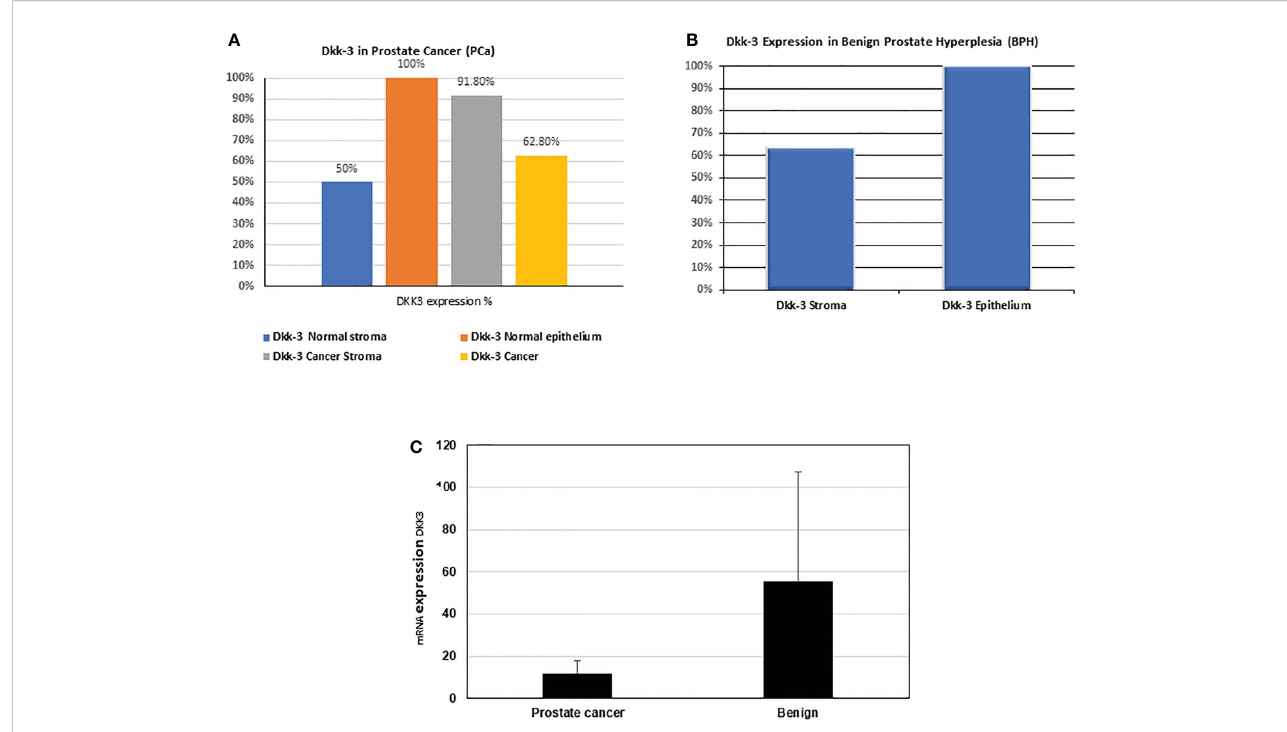
FIGURE 5 Percentage (%) of Dkk-3 expression in epithelium and stroma in our patients' cohort. (A) Dkk-3 expression in epithelium and stroma of cancer and normal adjacent tissue of nine PCa patients. (B) Dkk-3 expression in epithelium and stroma of being prostate hyperplasia tissue sections of fi ve BPH patients. (C) The mRNA expression levels (from the RNAseq data) of DKK3 in the PCa patients compared with